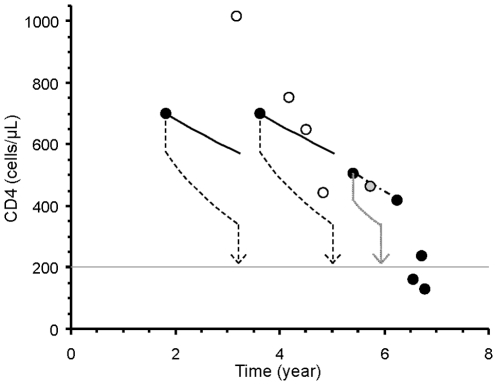
CD4 cell count data from an illustrative patient.The Snap-shot rule is applied to the first determination (closed circle) done 1.8 year after positive serology (discovered at time = 0), and indicates to repeat the test at 3.2 years (dashed arrow), when the CD4 count has 5% chance to reach 200 cells/µL. The second value actually measured at 3 years is thus declared superfluous and discarded (open circle). The rule is reapplied to the third value actually measured at 3.6 years, and designates the 3 next determinations as superfluous. The last 6 values fall below the threshold to question necessity. The treatment is actually initiated 7 years after HIV detection, once CD4 counts reach the threshold of 200 cells/µL. The lines indicate the average population slope. The Track-shot rule would give fairly similar results, except that it would indicate the 8th measurement as superfluous (dotted arrow and grey circle).